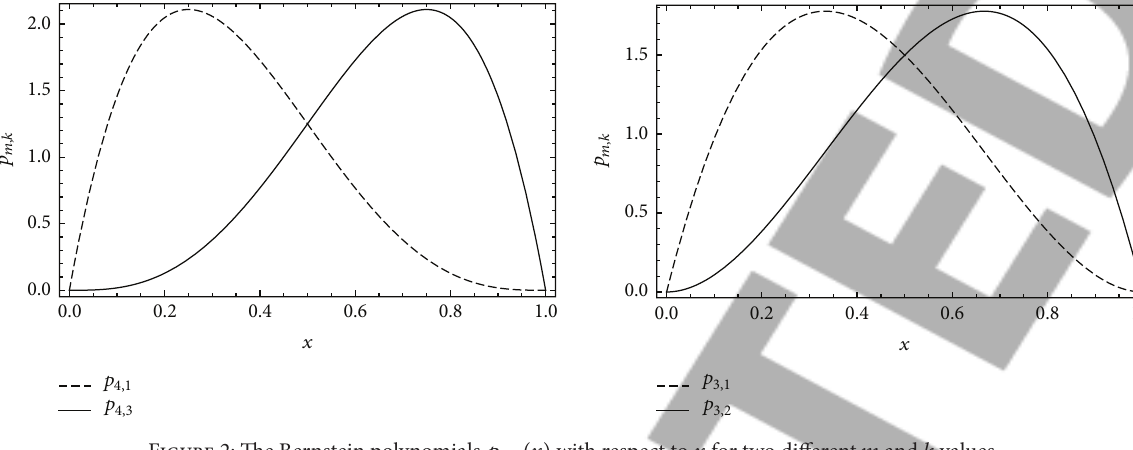
Figure 2: The Bernstein polynomials 𝑝 𝑚,𝑘 (𝑥) with respect to 𝑥 for two different 𝑚 and 𝑘 values.